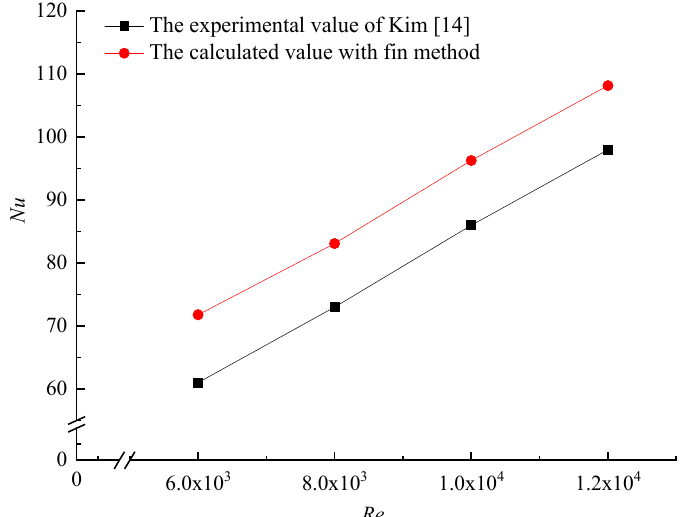
Figure 2. Comparison of the experimental value of Kim [14] and the calculated value with fin method.